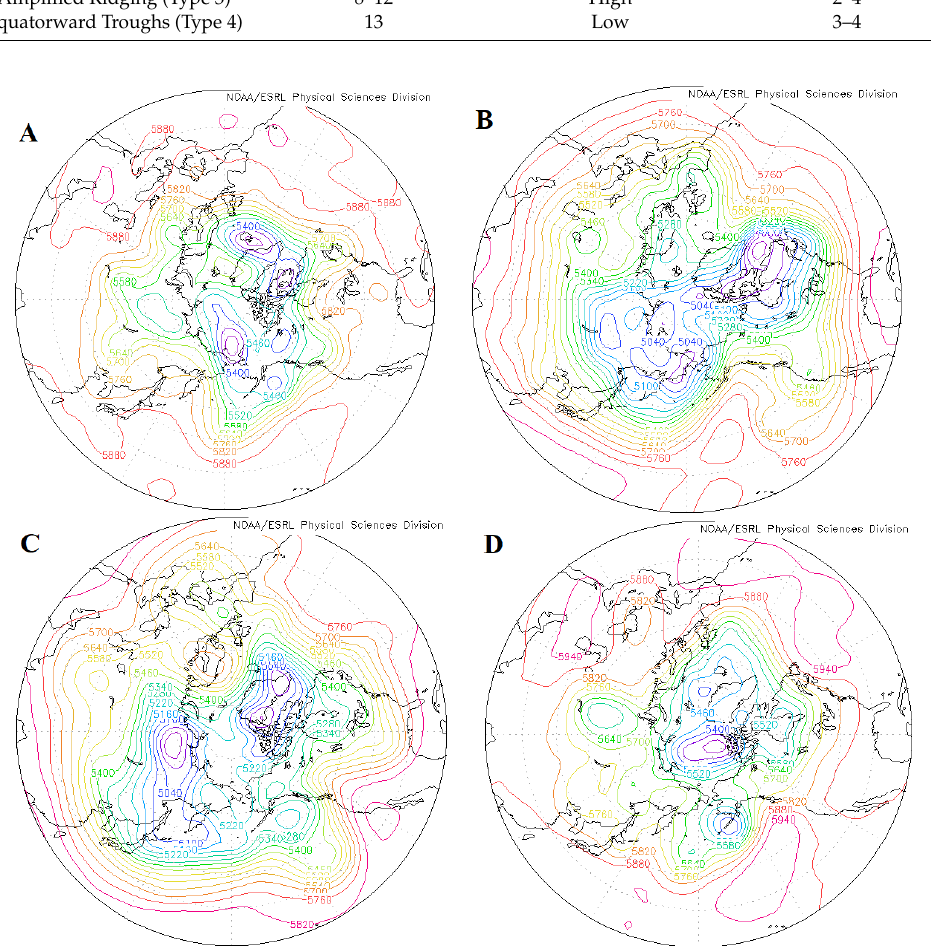
Figure 1. Adapted from [1] using data from [35], examples of the large-scale circulation types using the 1200 Coordinated Universal Time (UTC) 500 hPa height field. The contour intervals are 60 m and in color. The given examples are ( A ) Type 1 (26 August 2008—Elementary Circulation Mechanism (ECM) 2a), ( B ) Type 2 (19 February 2006—ECM 4a), ( C ) Type 3 (5 January 2006—ECM 10a), ( D ) Type 4 (10